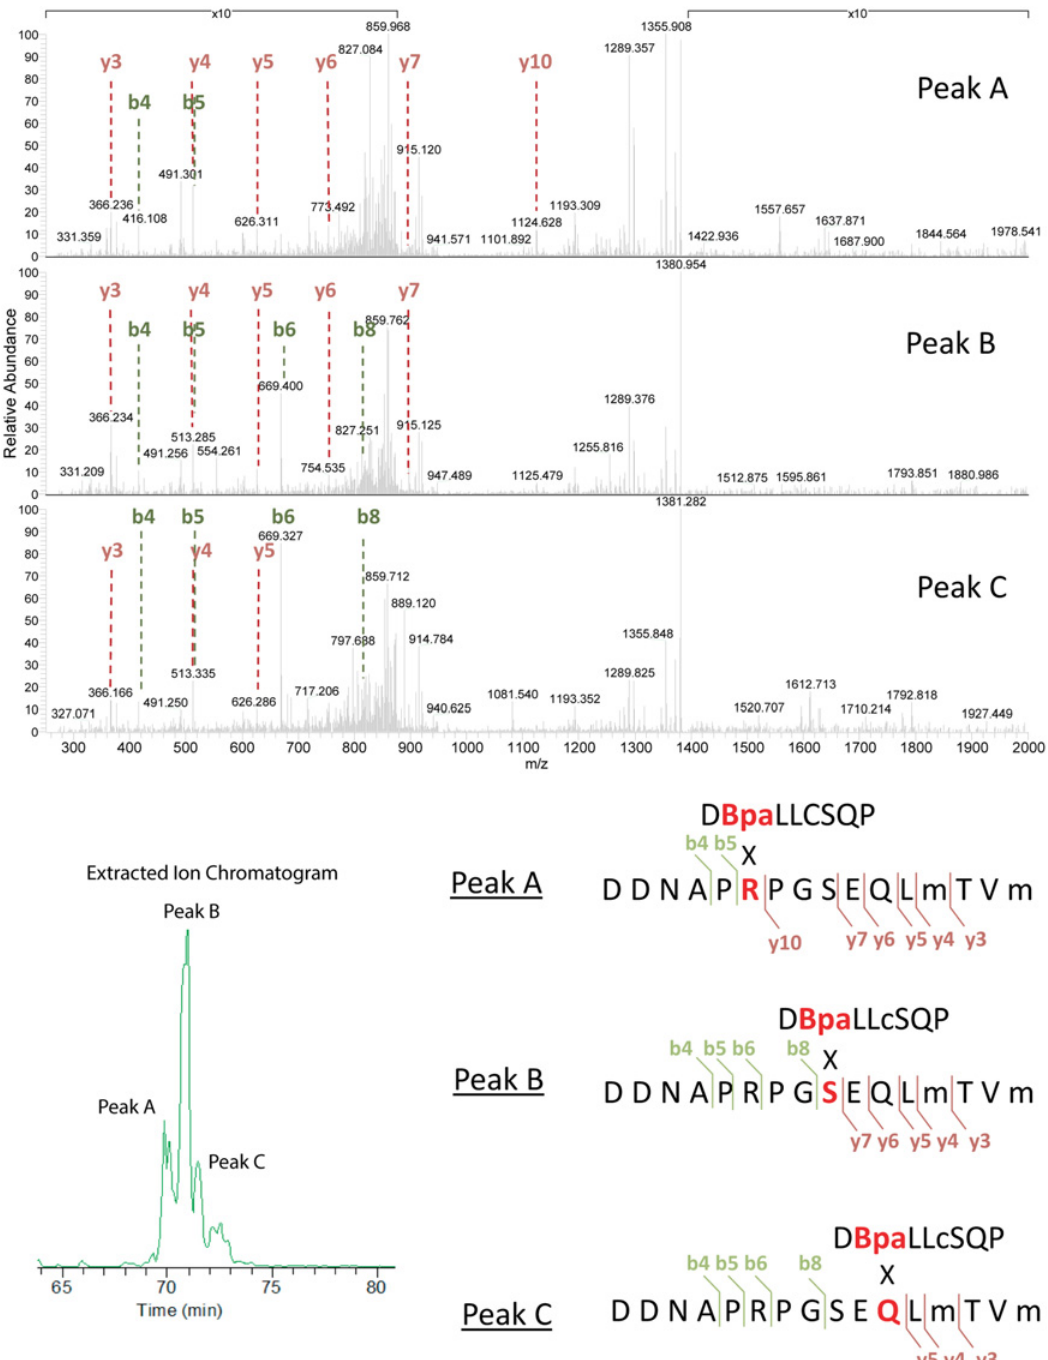
Fig 13. Analysis of cross-linked RecA-UmuC product #1. The first of the two identified cross-linked products appeared in samples generated via both active and inactive pol V protocols, although it seemed to be somewhat more prominent in the inactive samples. The UmuC peptide involved in the cross- linking encompasses residues 361 – 376. MS/MS spectra for each of the three peaks seen in the extracted ion chromatogram (Fig. 12) for the RecA-UmuC cross-linked product are shown at the top. The predicted crosslinking locations for peaks A,B, and C are shown at the bottom. The lettering corresponds to the unique elution profile for the same precursor